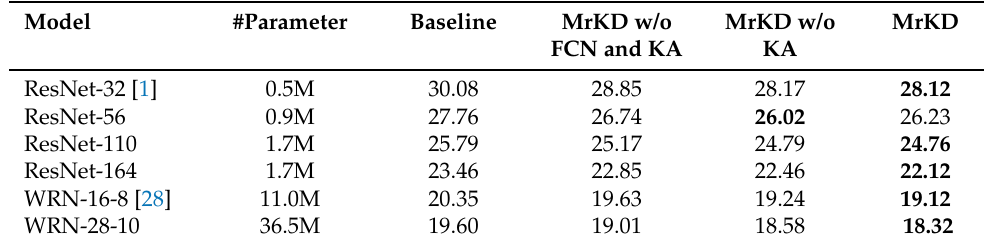
Table 3. Test error rate comparison on CIFAR-100 [26] dataset with different components. The ’w \ o’ stands for